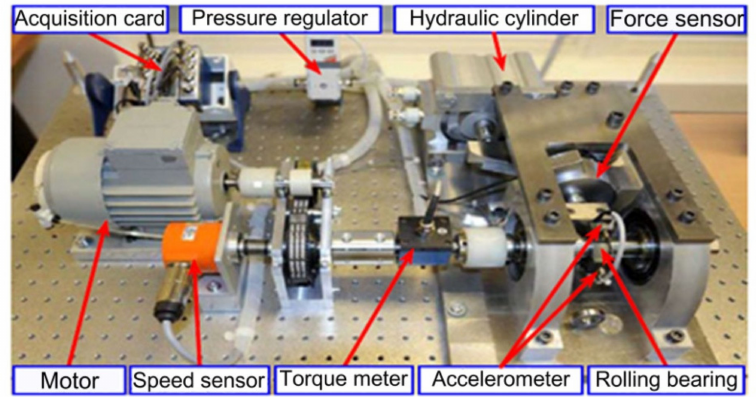
Figure 4. Target domain data set acquisition